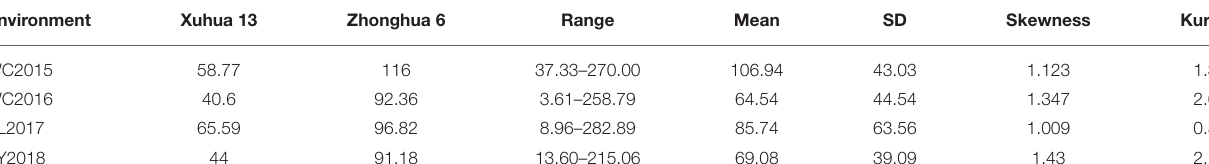
TABLE 1 | Descriptive statistics of resveratrol contents in the RIL population across four environments. Environment